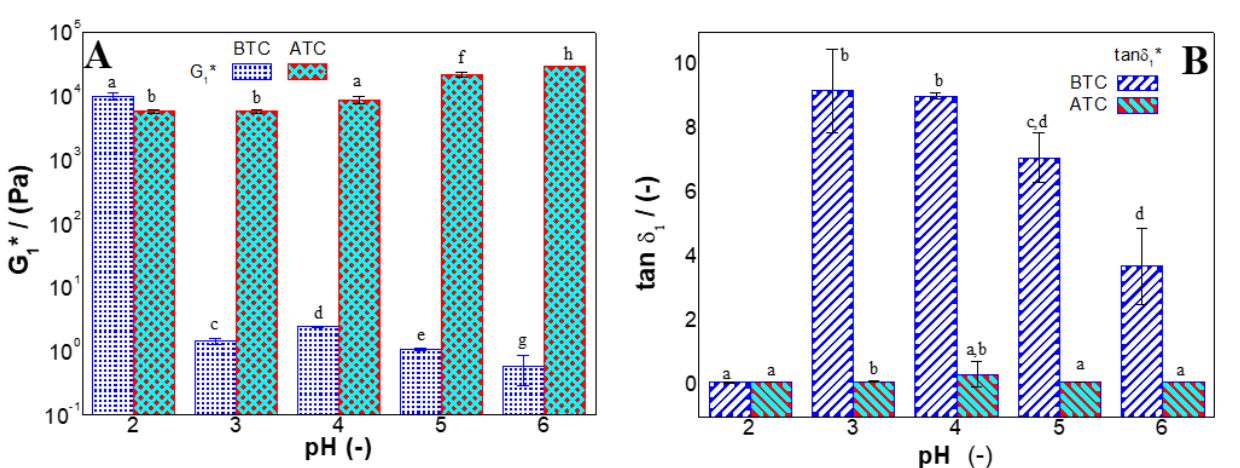
Figure 4. Values of complex moduli at 1 rad/s (G* 1 ) ( A ) and loss tangent at 1 rad/s (tan δ 1 ) ( B ) for the egg yolk acidulated with citric acid before thermal cycle (BTC) and after thermal cycle (ATC) as a function of pH (2, 3, 4, 5, and 6). Different letters above the bars indicate both significant differences ( p < 0.05) within G* 1 and tan δ 1 in each figure,